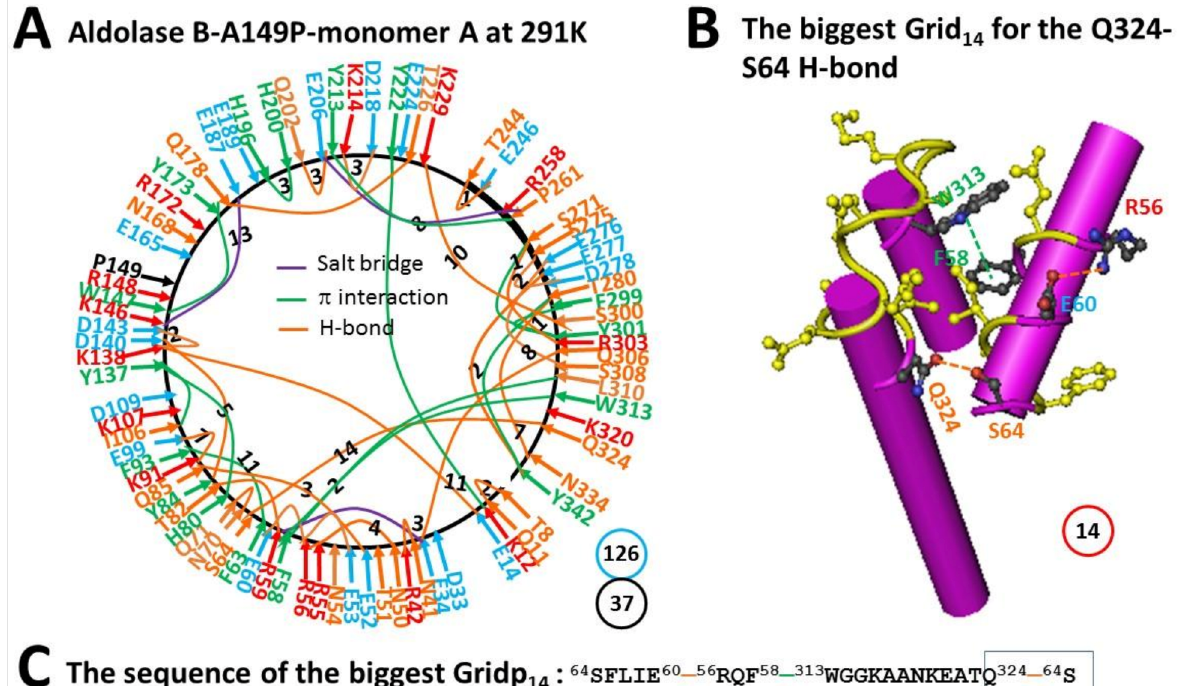
Figure 4. The grid-like non-covalently interacting mesh network along the single polypeptide chain of ligand-free monomer A in the aldolase B-A149P tetramer at 291 K. ( A ) The topological grids in the systemic fluidic grid-like mesh network. The X-ray crystallographic structure of monomer A in aldolase B-A149P at 291 K (PDB ID, 1XDM) was used for the model [2]. Salt bridges, π interactions, and H-bonds between pairing amino acid side chains along the single polypeptide chain from T8 to Y342 are marked in purple, green, and orange, respectively. The grid sizes required to control the relevant non-covalent interactions were calculated with graph theory and labeled in black. The total grid sizes and grid size-controlled non-covalent interactions along the single polypeptide chain are shown in the blue and black circles, respectively. ( B ) The structure of the biggest Grid 14 . The grid size is shown in a red circle. ( C ) The sequence of the biggest Grid 14 to control the S64-Q324 H-bond in a blue